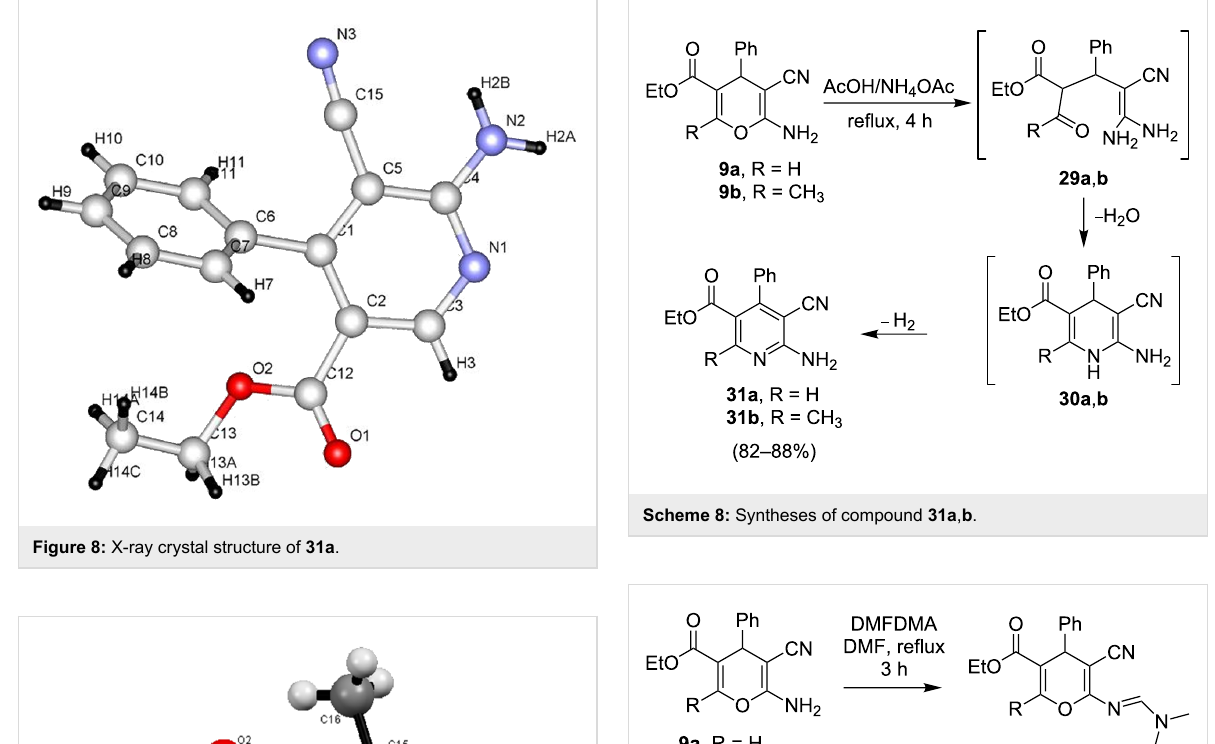
Figure 8: X-ray crystal structure of 31a .